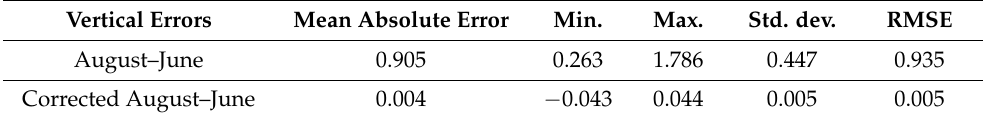
Table 8. Characterisation of DTMs by elevation values (m) obtained for the area of interest (AOI).